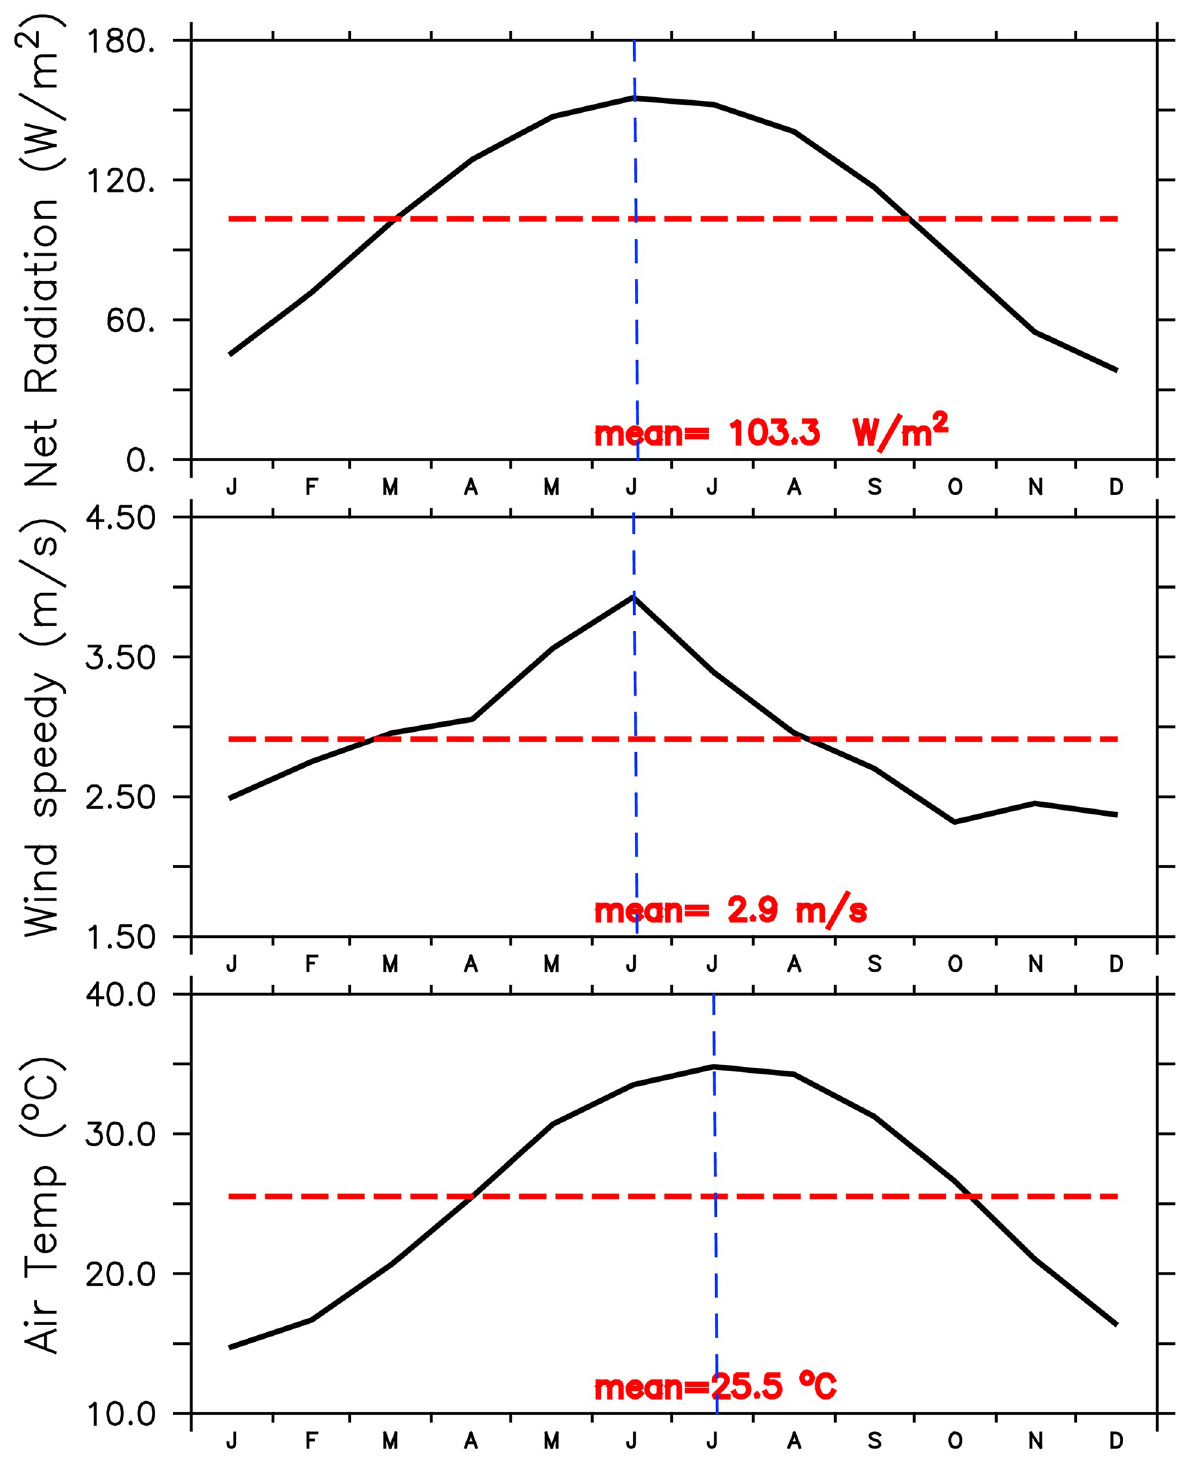
Fig 2. Seasonal variation of the basin-averaged net shortwave radiation, wind speed and air temperature form NCEP.